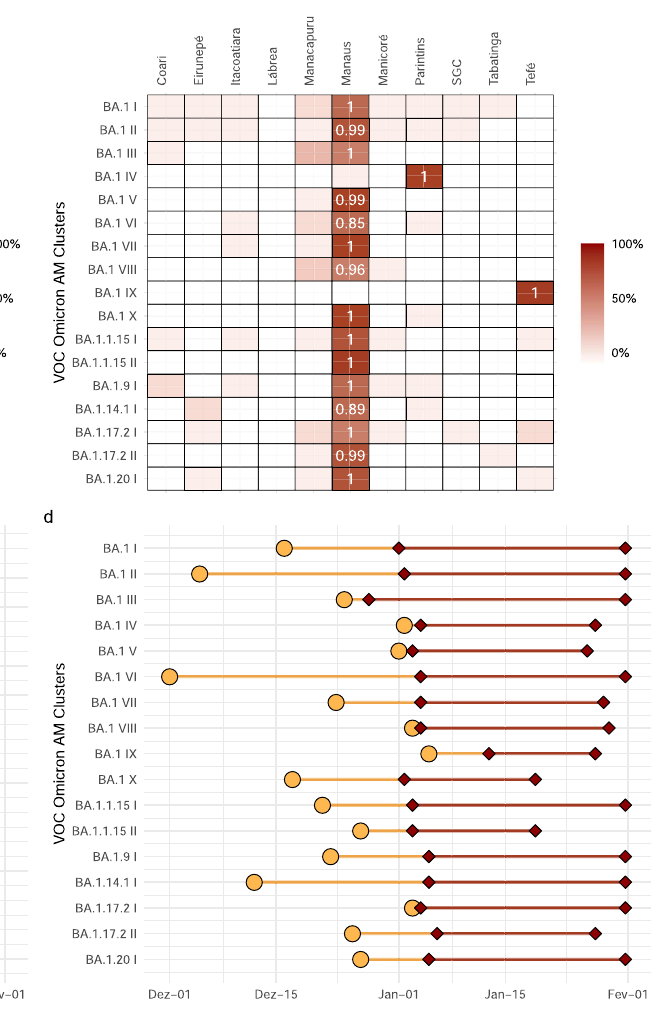
Fig.6|Identi fi cationofmajorDeltaandOmicronBA.1transmissionlineagesin Amazonas state. a , b Heatmap cells are colored according to the proportion of Delta and Omicron sequences from different state regions within each major Amazonian transmission lineage. Numbers indicate the posterior state probability ( PSP )ofthemostprobablesourcelocation. c , d TimelineofmajorAmazonianDelta